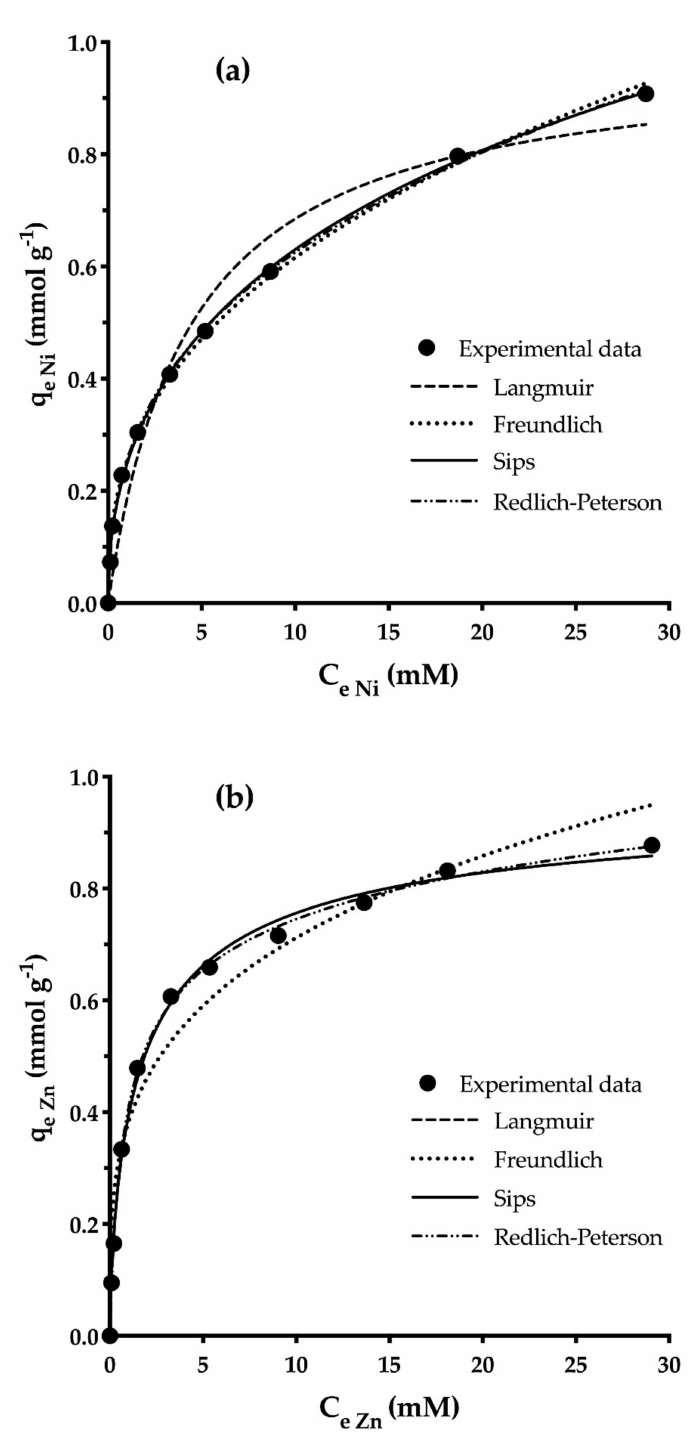
Figure 4. Isotherms of Ni 2 + ( a ) and Zn 2 + ( b ) biosorption on Lemna gibba in single metal